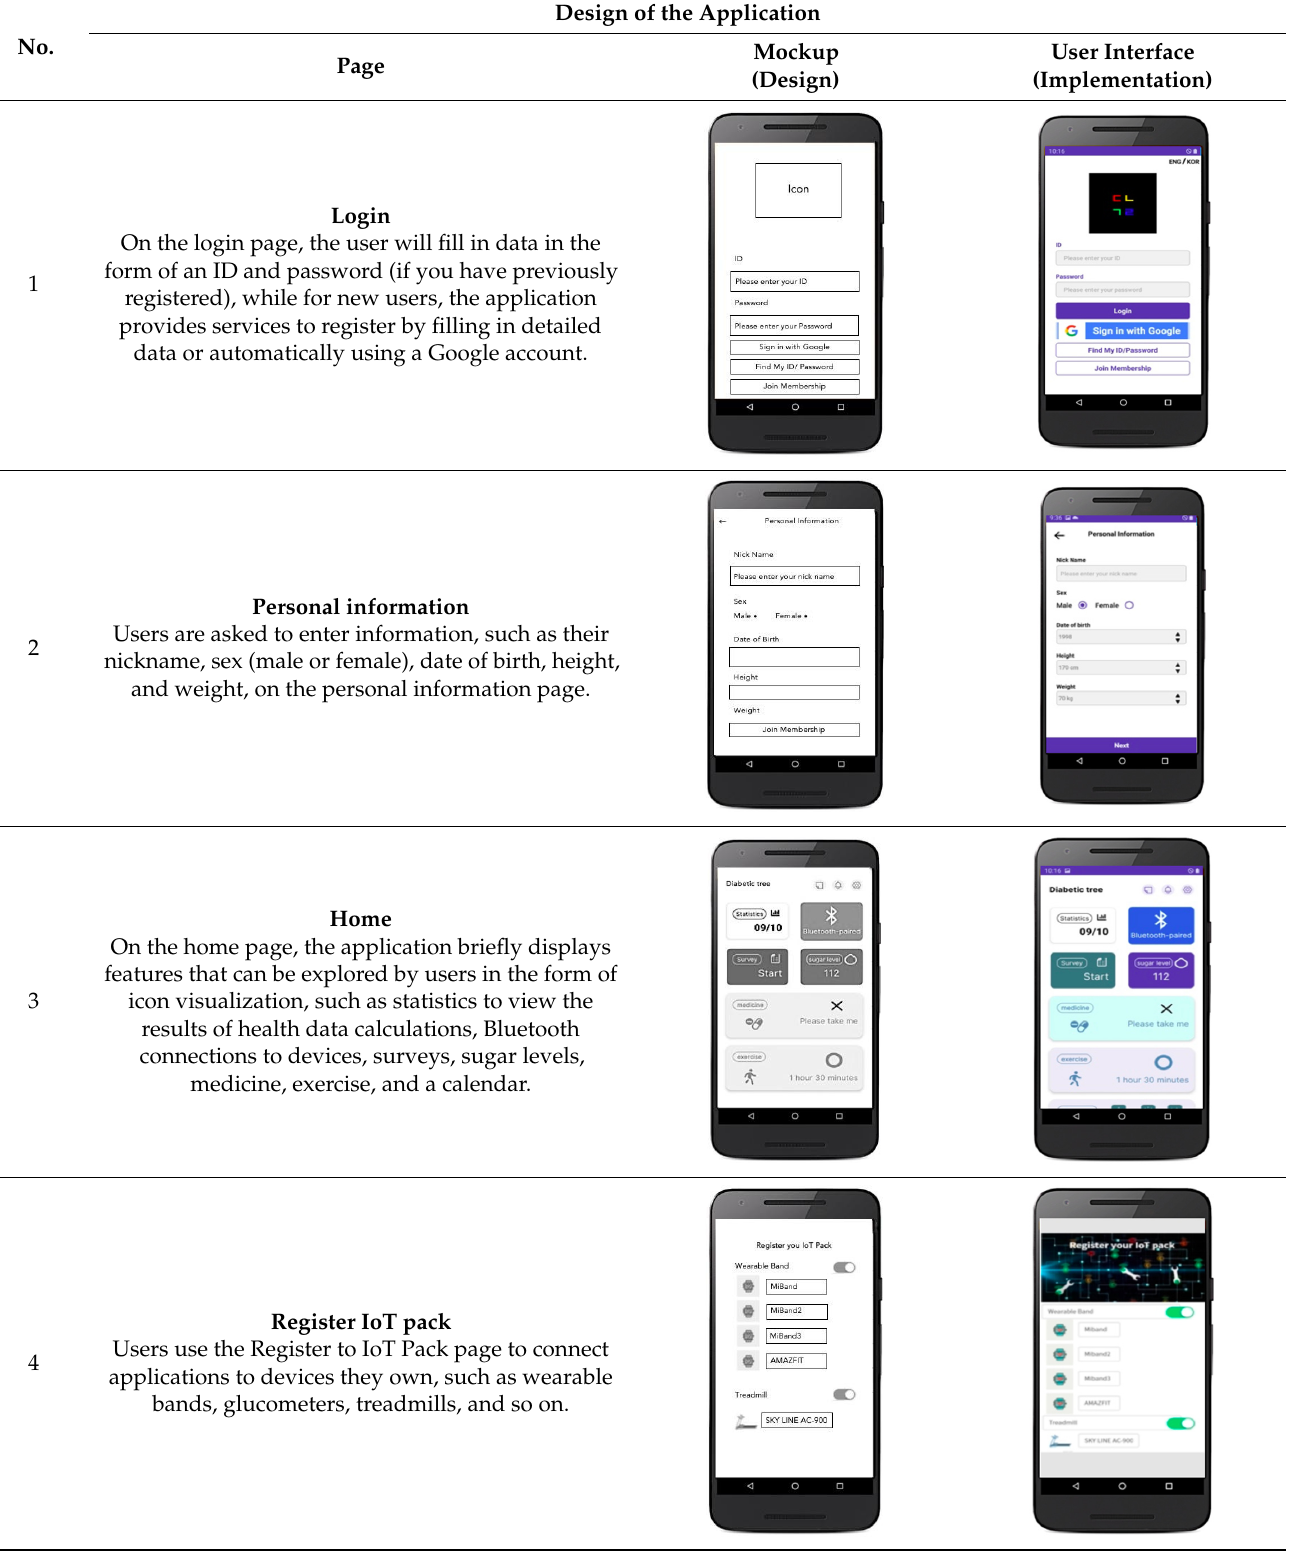
Table 7. Design of the Application.